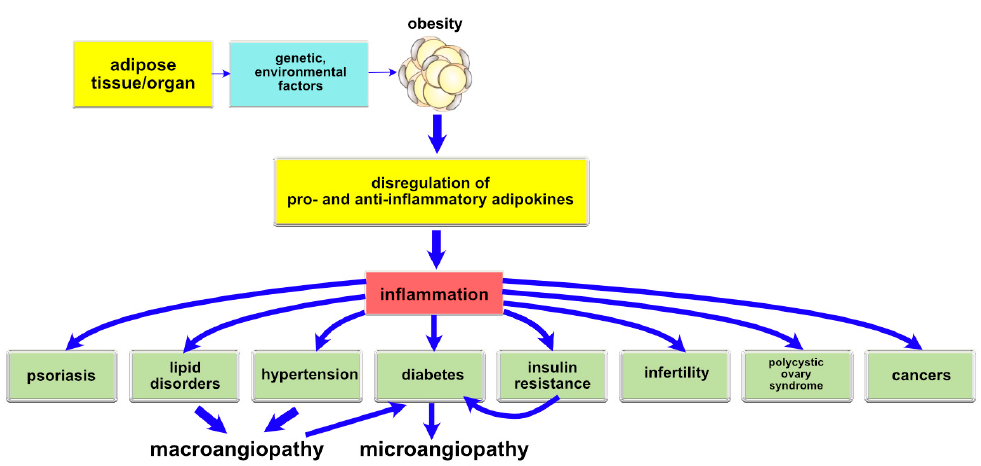
Figure 2. The disregulation pathway of adipokines potentially leading to metabolic disorders and chronic complications in the course of obesity.